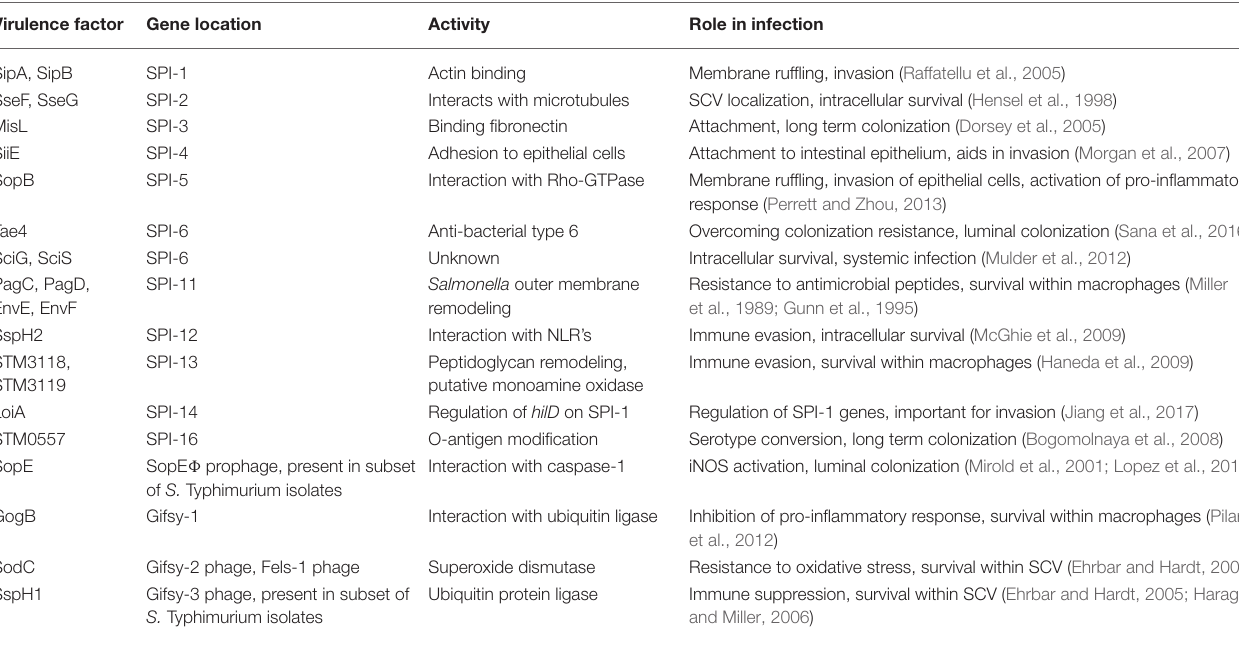
TABLE 1 | Summary of horizontally acquired genes and their role in Salmonella interaction with host